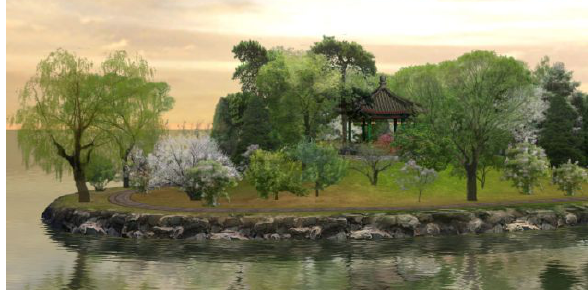
Figure 11.Plants scene after the adjustment